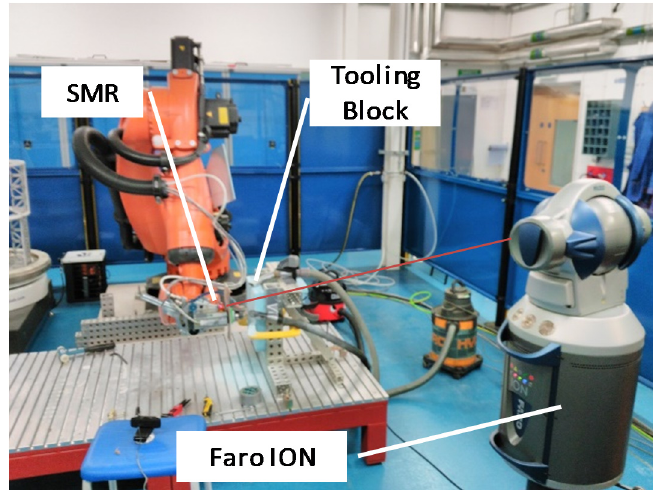
Figure 19. Picture of robot drilling test block under real-time laser tracker compensation.